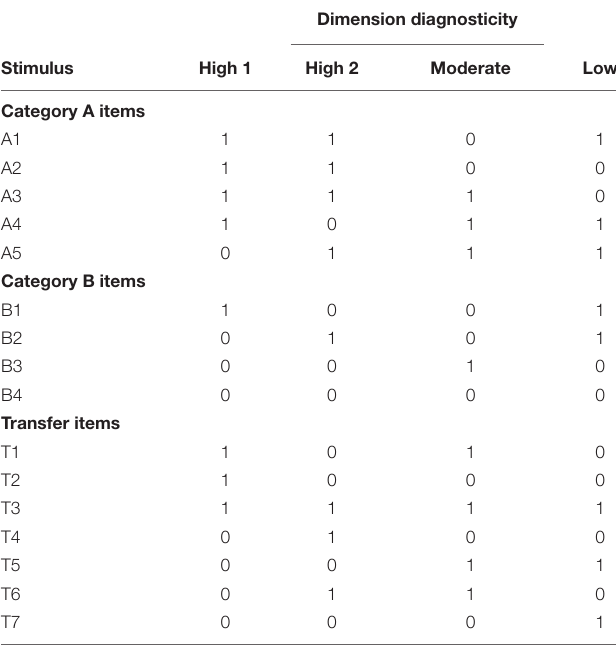
TABLE 1 | Category membership (category A or B) based on features. The likelihood of a feature to be uniquely associated with a category determined its diagnosticity level (low, moderate,